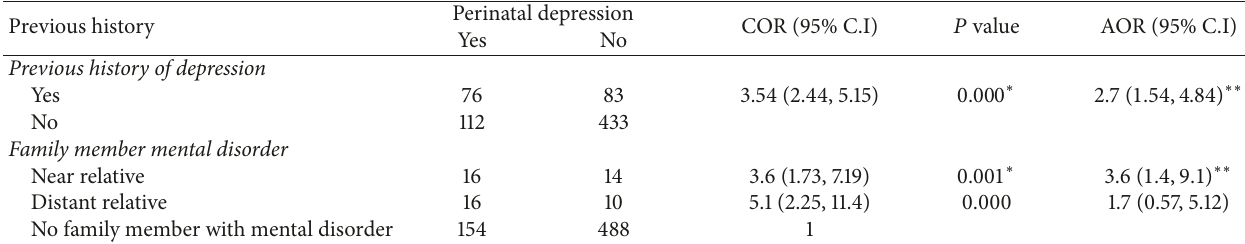
Table 6: Analysis of previous history of mental disorders factors of participants associated with perinatal depression, Arba Minch Zuria District, Ethiopia, March,